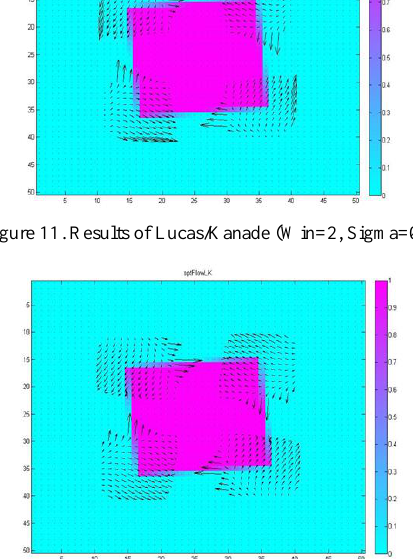
Figure 10. Results of Lucas/Kanade (Win=2, Sigma=0.1)